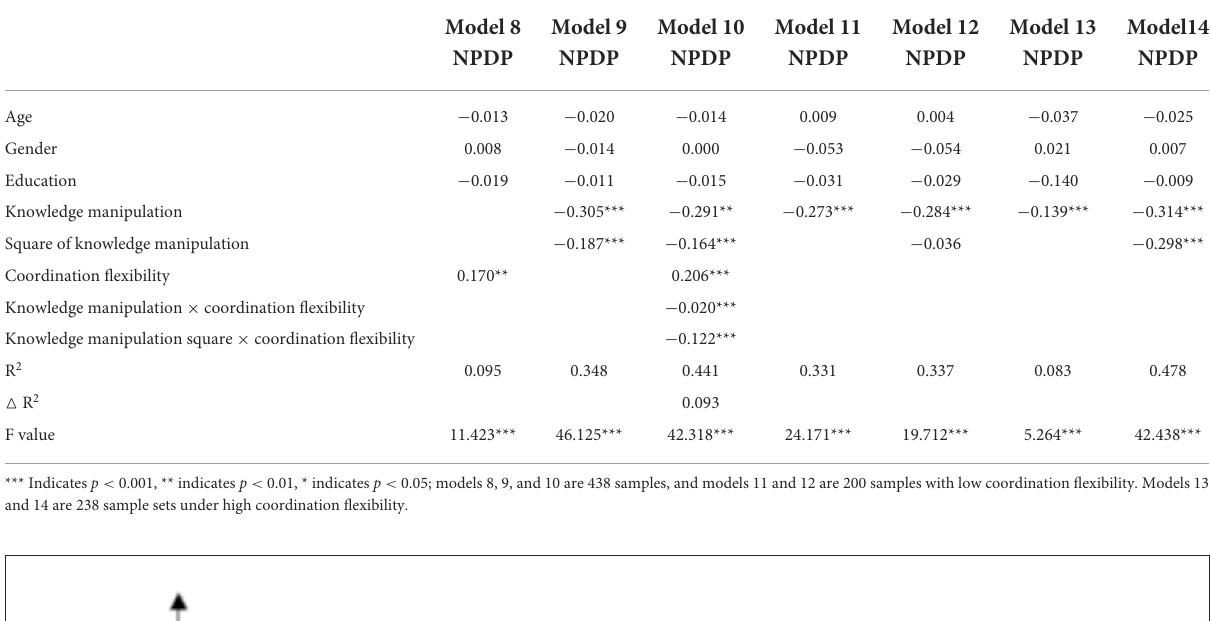
TABLE 5 Relationship test between knowledge manipulation, coordination flexibility and new product development performance.